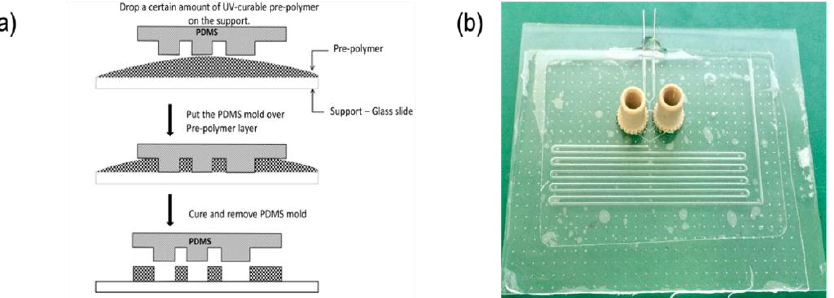
Figure 1. Micro-molding technique for fabrication of microfluidic systems ( a ) and the real microfluidic chip ( b ).